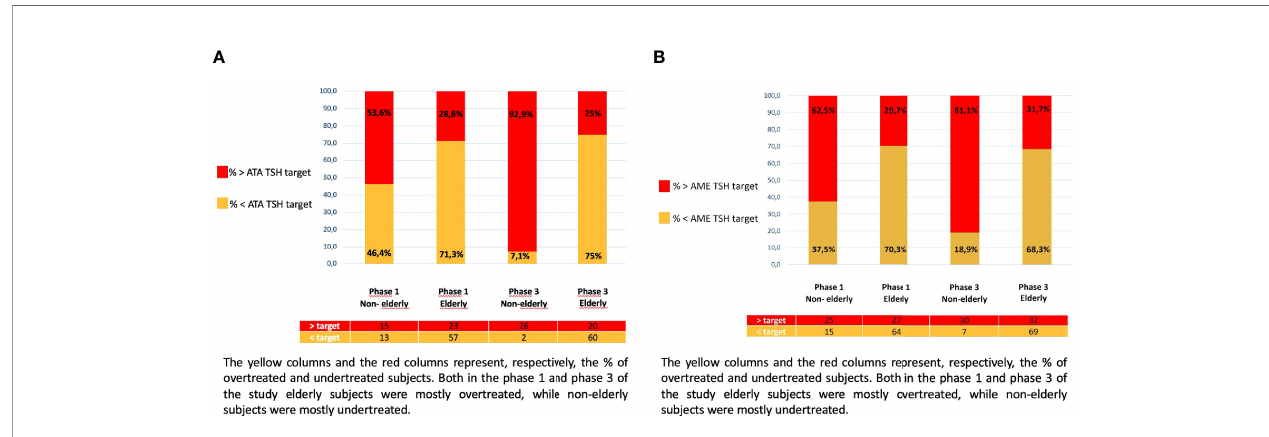
FIGURE 2 | (A) Patients under and overtreated in relation to the ATA TSH target, in phase 1 and 3 of the study: elderly and non-elderly. The yellow columns and the red columns represent, respectively, the % of overtreated and undertreated subjects. Both in the phase 1 and phase 3 of the study elderly subjects were mostly overtreated, while non-elderly subjects were mostly undertreated. (B) Patients under and overtreated in relation to the AME TSH target, in phase 1 and 3 of the study: elderly and non-elderly. The yellow columns and the red columns represent, respectively, the % of overtreated and undertreated subjects. Both in the phase 1 and phase 3 of the study elderly subjects were mostly overtreated, while non-elderly subjects were mostly